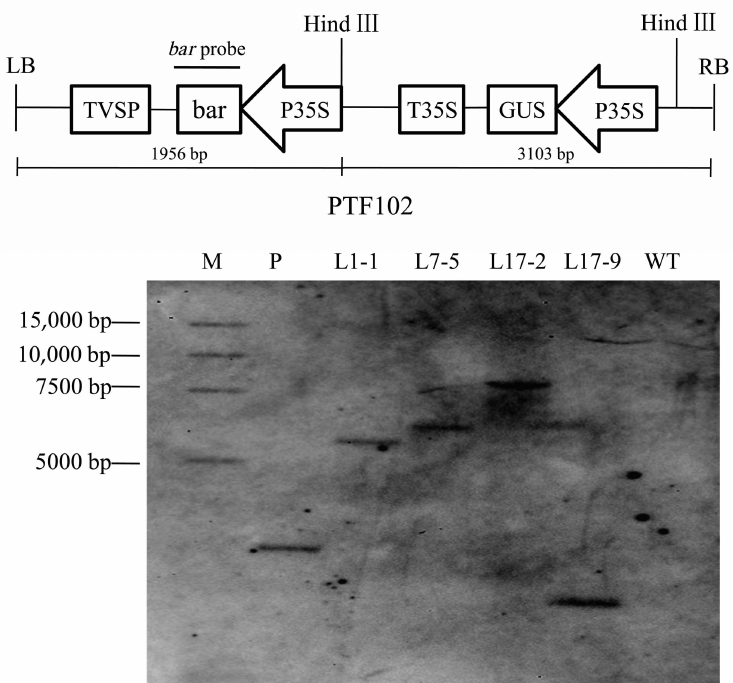
Figure 4. Southern blot analysis of T1 transgenic plants. Plasmid and genomic DNA were digested with HindIII, and hybridized with the bar probe labeled with DIG. M: marker; P: plasmid DNA of pWMB123; L1-1: DNA from T1 plant with bar + from transgenic line 1; L7-5: DNA from T1 plant with bar + from transgenic line 7; L17-2 and L17-9: DNA from T1 plant with bar + from transgenic line 17. WT: DNA from nontransgenic